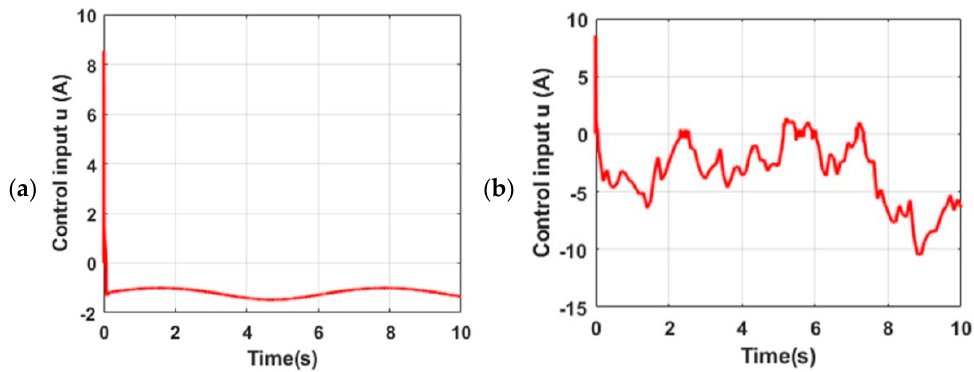
Figure 6 . f n and its estimate. ( a ) Non-interference signal. ( b ) C-level road surface.